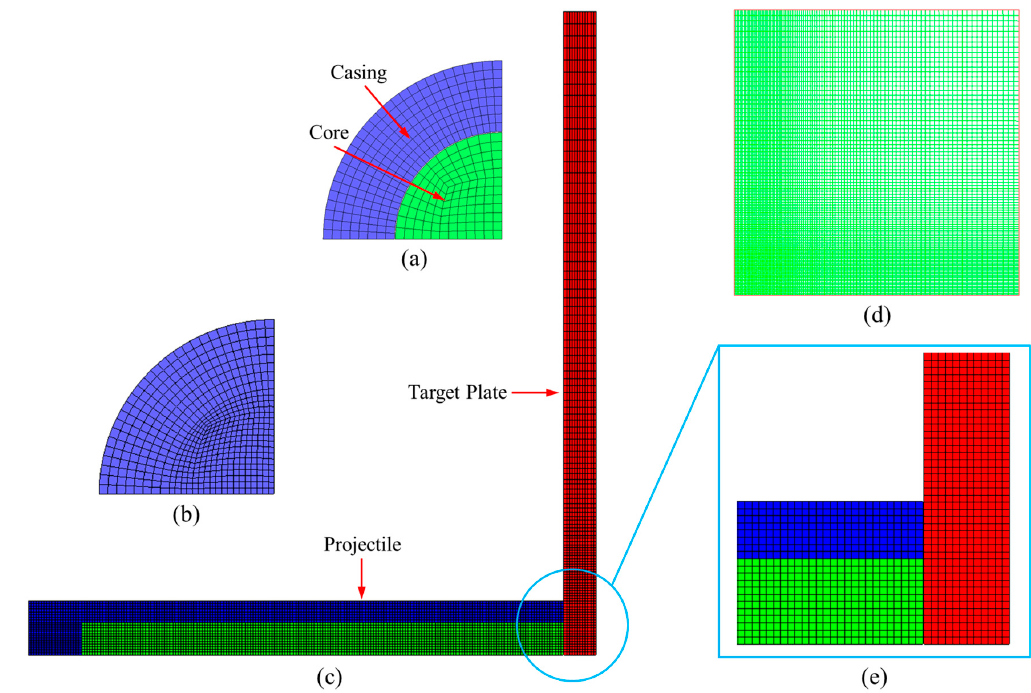
Figure 11. Schematic diagram of the finite element model. ( a ) Projectile head, ( b ) Projectile rear, ( c ) FE model, ( d ) Target plate grid, and ( e ) Impact region.